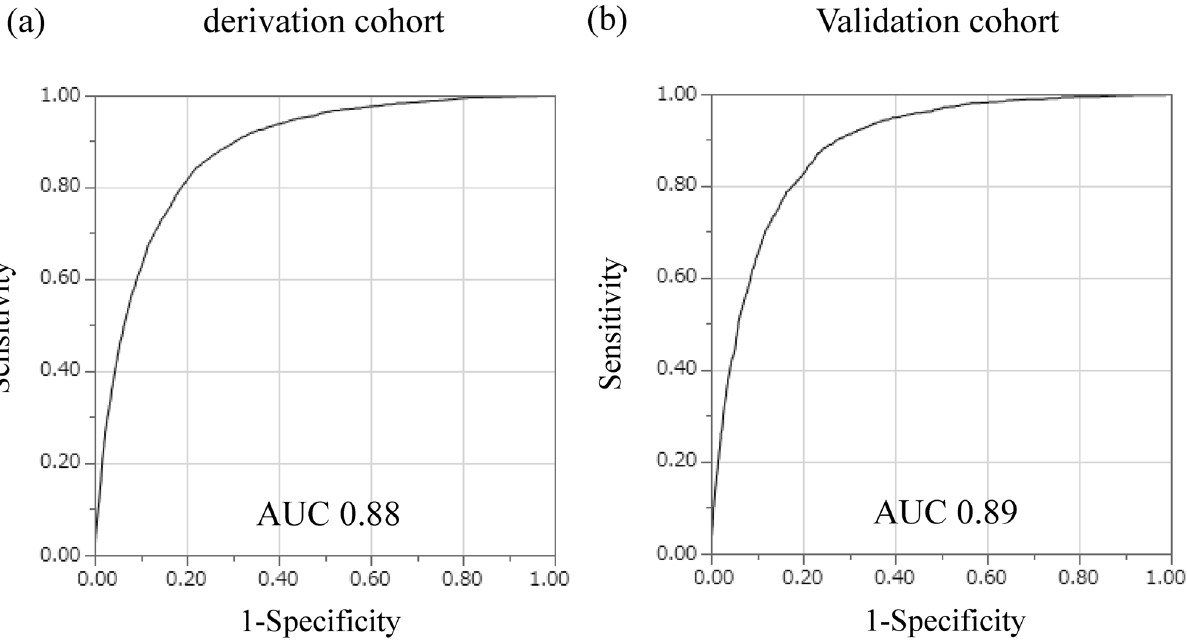
Figure 3. ROC curves in the derivation and validation cohorts for the risk equation for predicting the 5-year incidence of CKD. Receiver operating characteristic curves of the derivation cohort ( a ) and validation cohort ( b ) for the risk equation to predict the 5-year incidence of CKD. AUC area under the curve, CKD chronic kidney disease, ROC receiver operating characteristic.